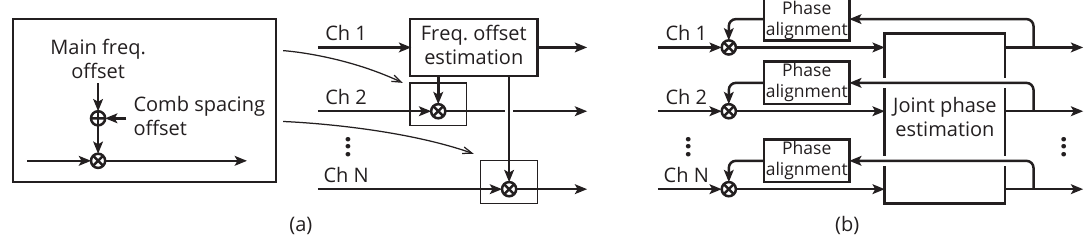
Figure 7. ( a ) Master-slave frequency offset compensation for unsynchronized combs; ( b ) feedback phase alignment for joint phase